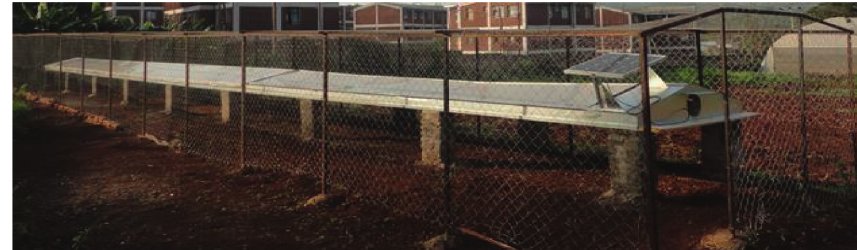
Figure 1: Photograph of the twin layer solar tunnel